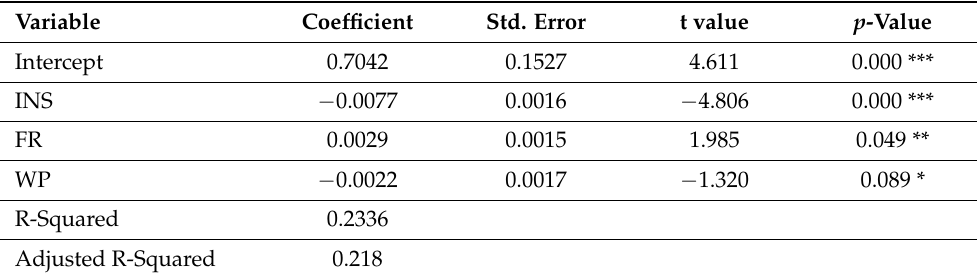
Table 8. Results of regression